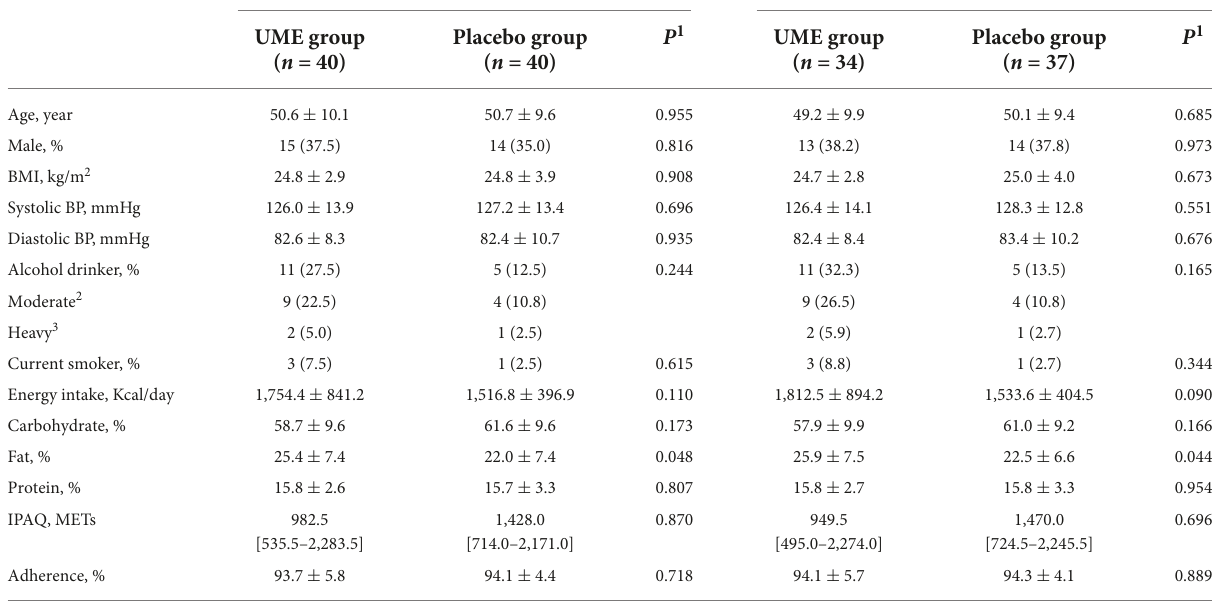
TABLE 1 Baseline characteristics of the study group.